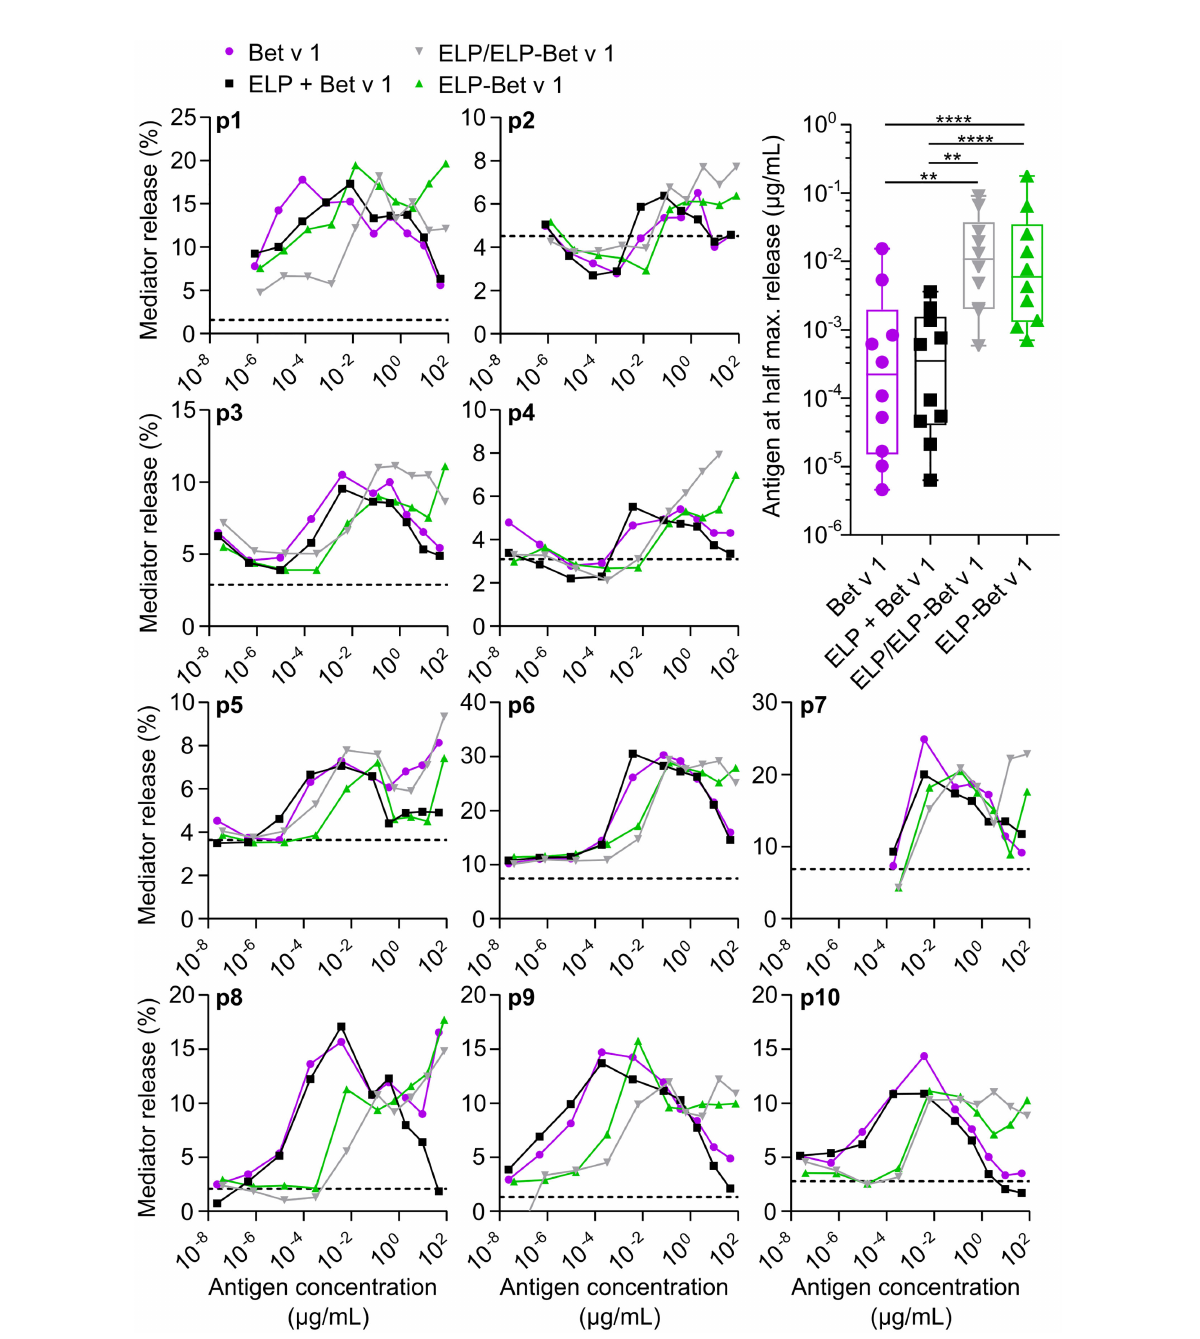
FIGURE 6 RBL assay. Mediator release from rat basophils displaying human IgE from 10 patients (p1-p10) were measured following incubation with a series of antigen concentrations. The level of mediator release in the absence of antigen is depicted as a dashed line. The CMC of ELP/ELP-Bet v 1 (0.39 µg/mL) and ELP-Bet v 1 (19 µg/mL) are located closely together but are not indicated in this fi gure to maintain clarity. Right shifted curves indicate higher concentrations required to get the same level of mediator release. This hypo-allergenicity is quanti fi ed by determining the Bet v 1 concentration at half the maximum value of mediator release on the left side of the peak. *p<0.05, **p<0.01, ***p<0.001,